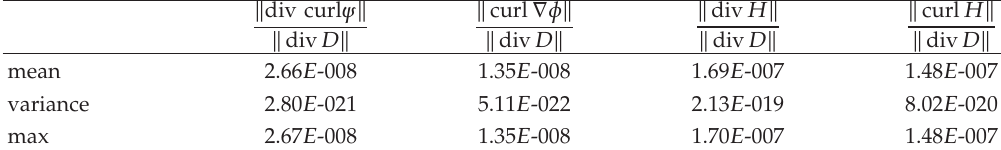
Table 2: Random fourth-order tensor fitting